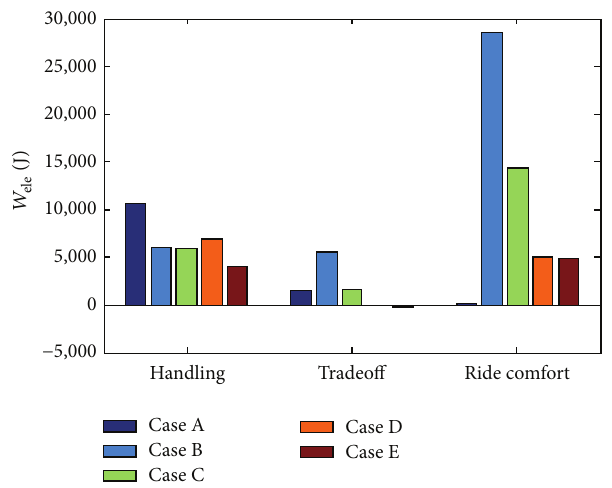
Figure 12: Energy consumption of linear